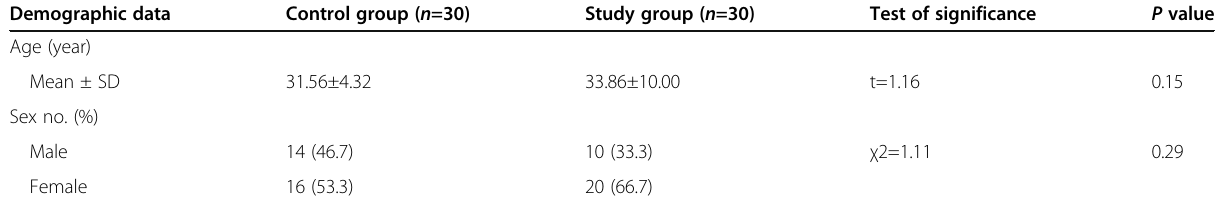
Table 1 Demographic data of the control and study groups Demographic data